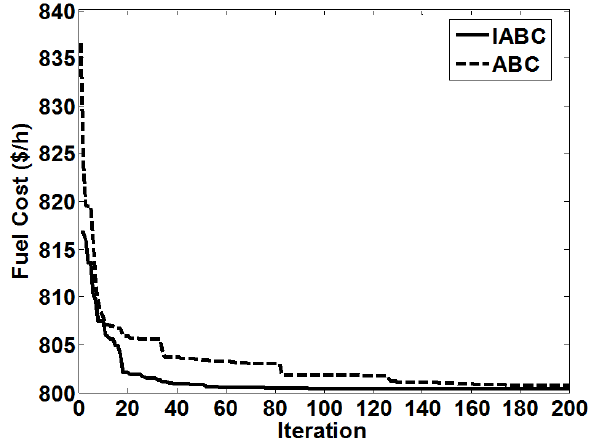
Figure 7. Convergence characteristics of fuel cost for the IABC and ABC algorithms for an IEEE 30-bus